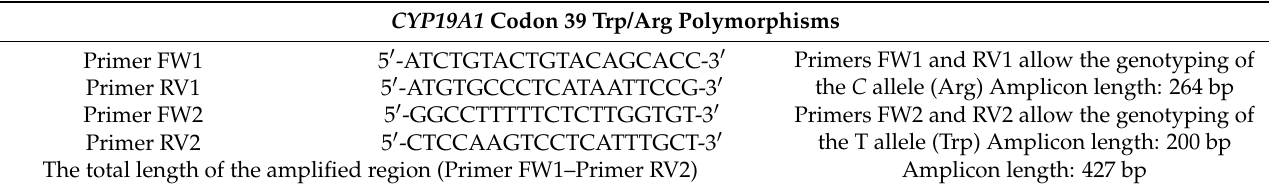
Table 1. CYP19A1 codon 39 Trp/Arg polymorphisms.